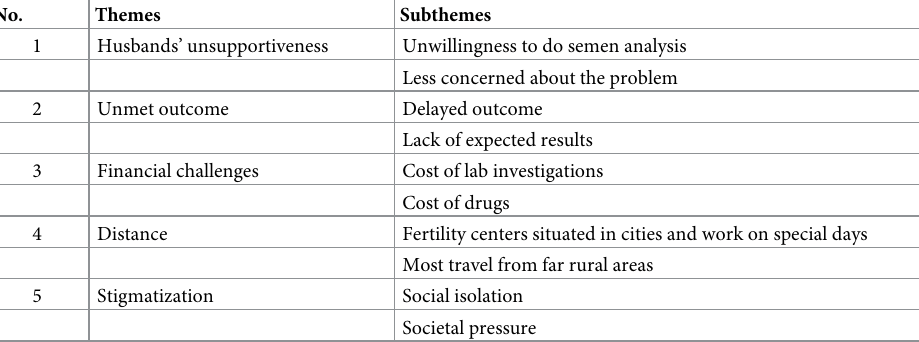
Table 4. Themes and subthemes from key informant interviews.